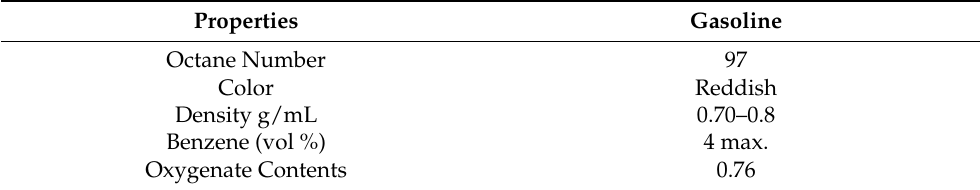
Table 2. Properties of